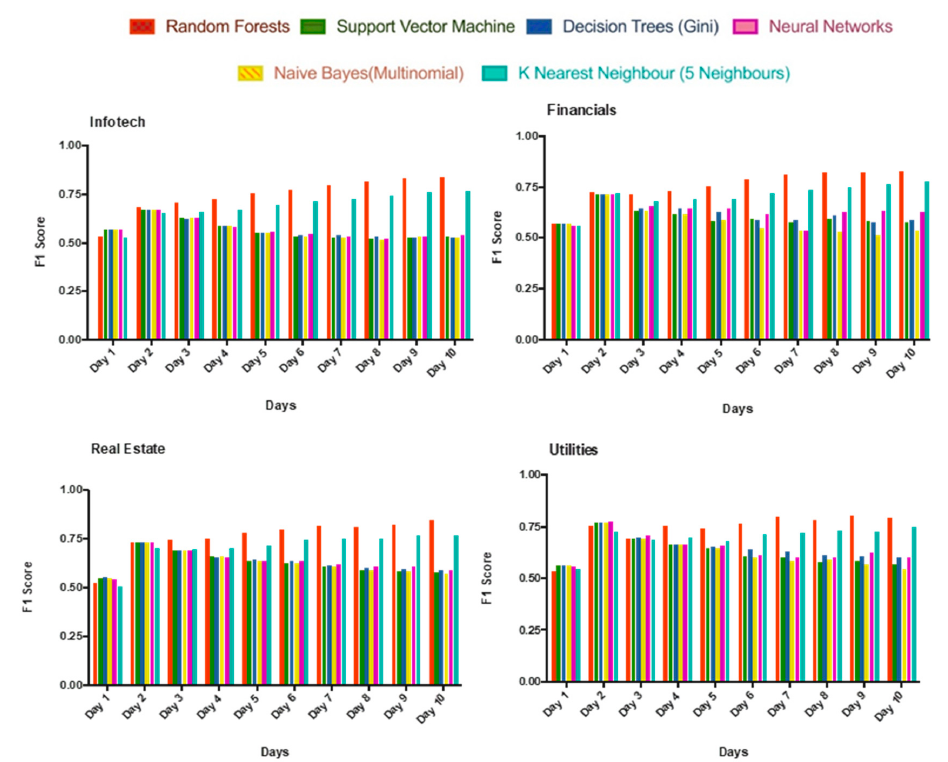
Figure 4. Performance of classifiers in a few selected sectors.